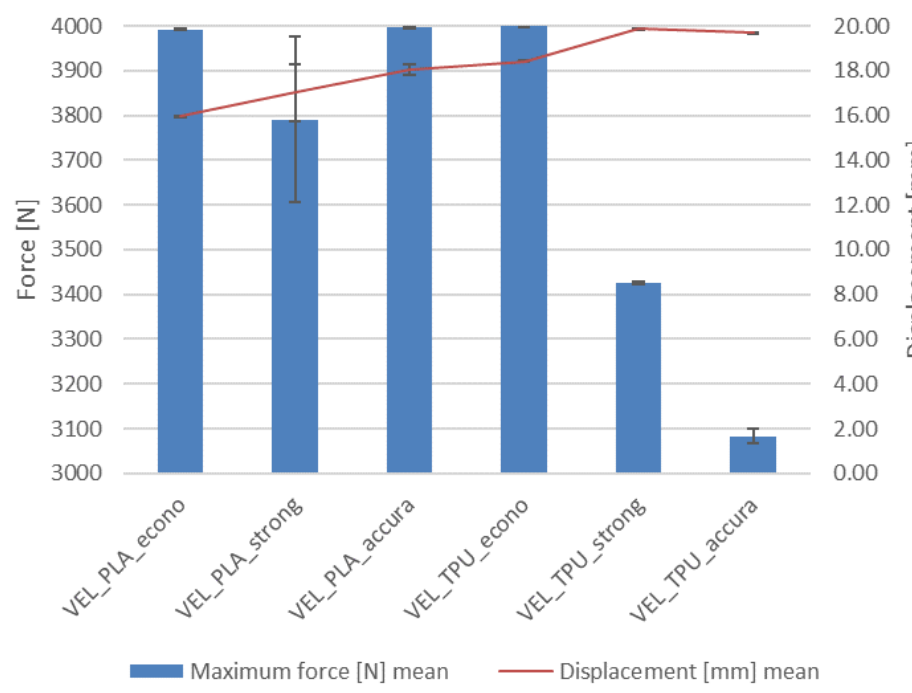
Figure 20. Strength test results for the Velcro sockets.